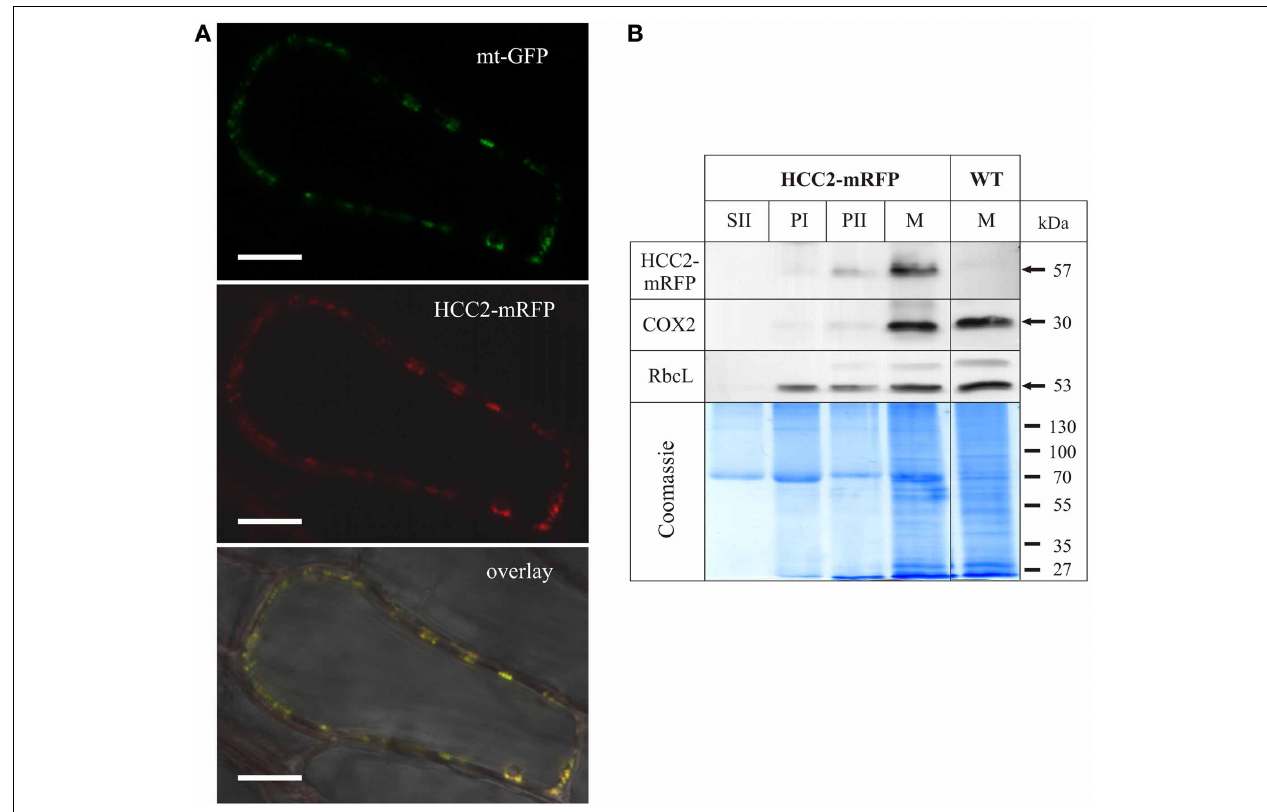
FIGURE 4 | Subcellular localization analysis of HCC2-mRFP. (A) Five different transgenic lines co-expressing HCC2-mRFP and GFP targeted to mitochondria (mt-GFP) were imaged by laser scanning microscopy, and co-localization of HCC2-mRFP and mt-GFP was found in each line. A representative cell (line 3) is shown, in which co-localization of the green mt-GFP (top panel) and the red HCC2-mRFP signals (middle panel) is depicted as yellow signals after merging the two images (overlay). The overlay also includes a bright-field image of the cell. The image was acquired with a resolution of 1024 × 1024 pixels and a pixel dwell of 3.15 μ s. Scale